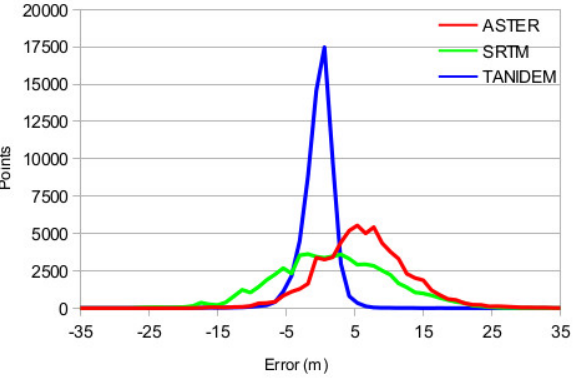
Figure 6. Psarrou study site. Histogram of the elevation differ- ences of the 3 global DEMs with respect to the local DTM data using 64164 points. (DX,DY,DZ)=(0,0,0).